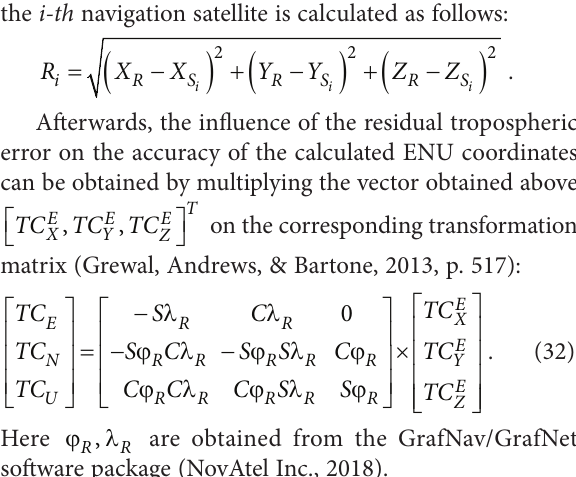
Figure 12. Vertical component of the residual tropospheric error’s influence on coordinate